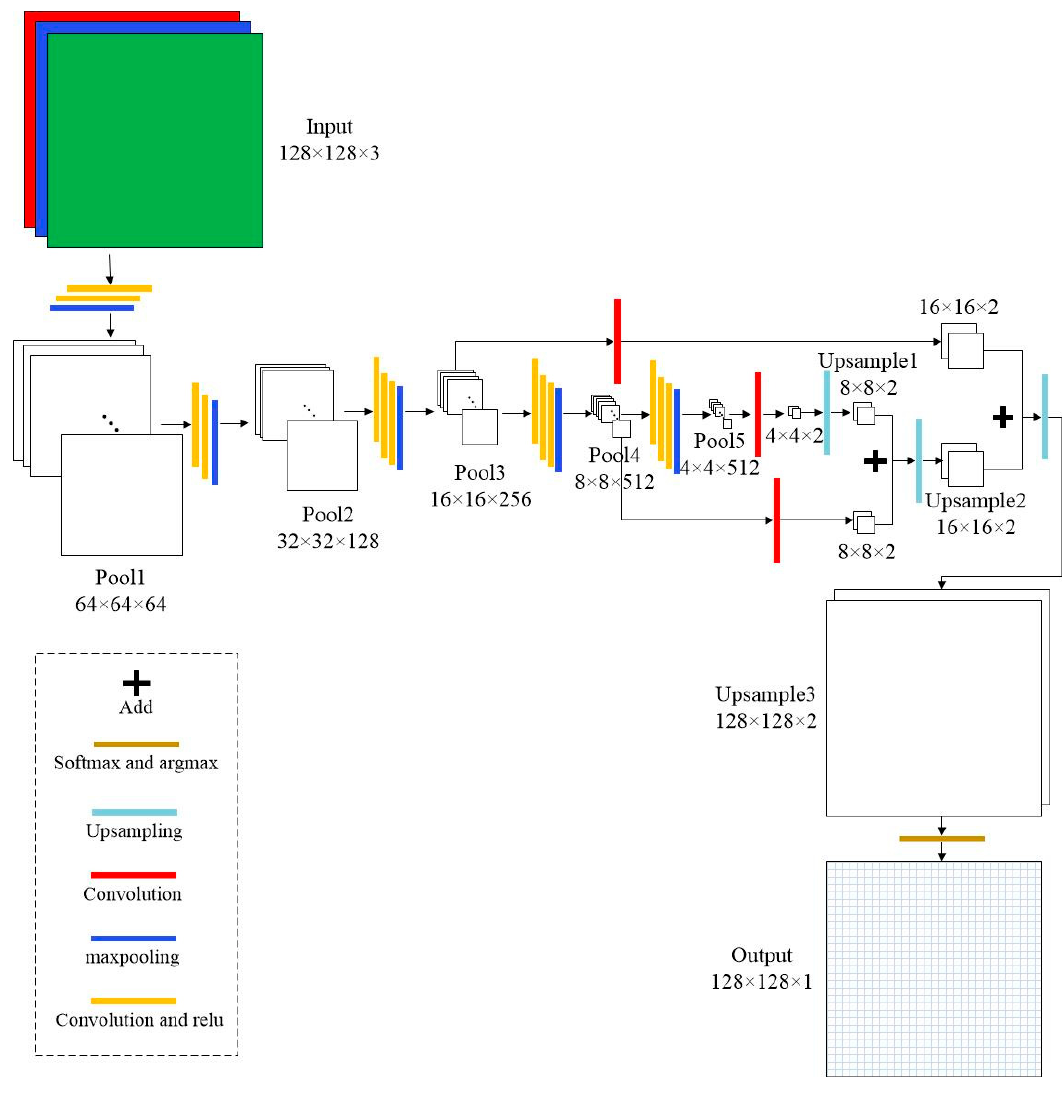
Figure 4. The architecture of the FCN model used in our experiments. The white boxes indicate image features with their sizes shown in the box. Color bars represent modules with specific functions as explained at the lower-left corner.